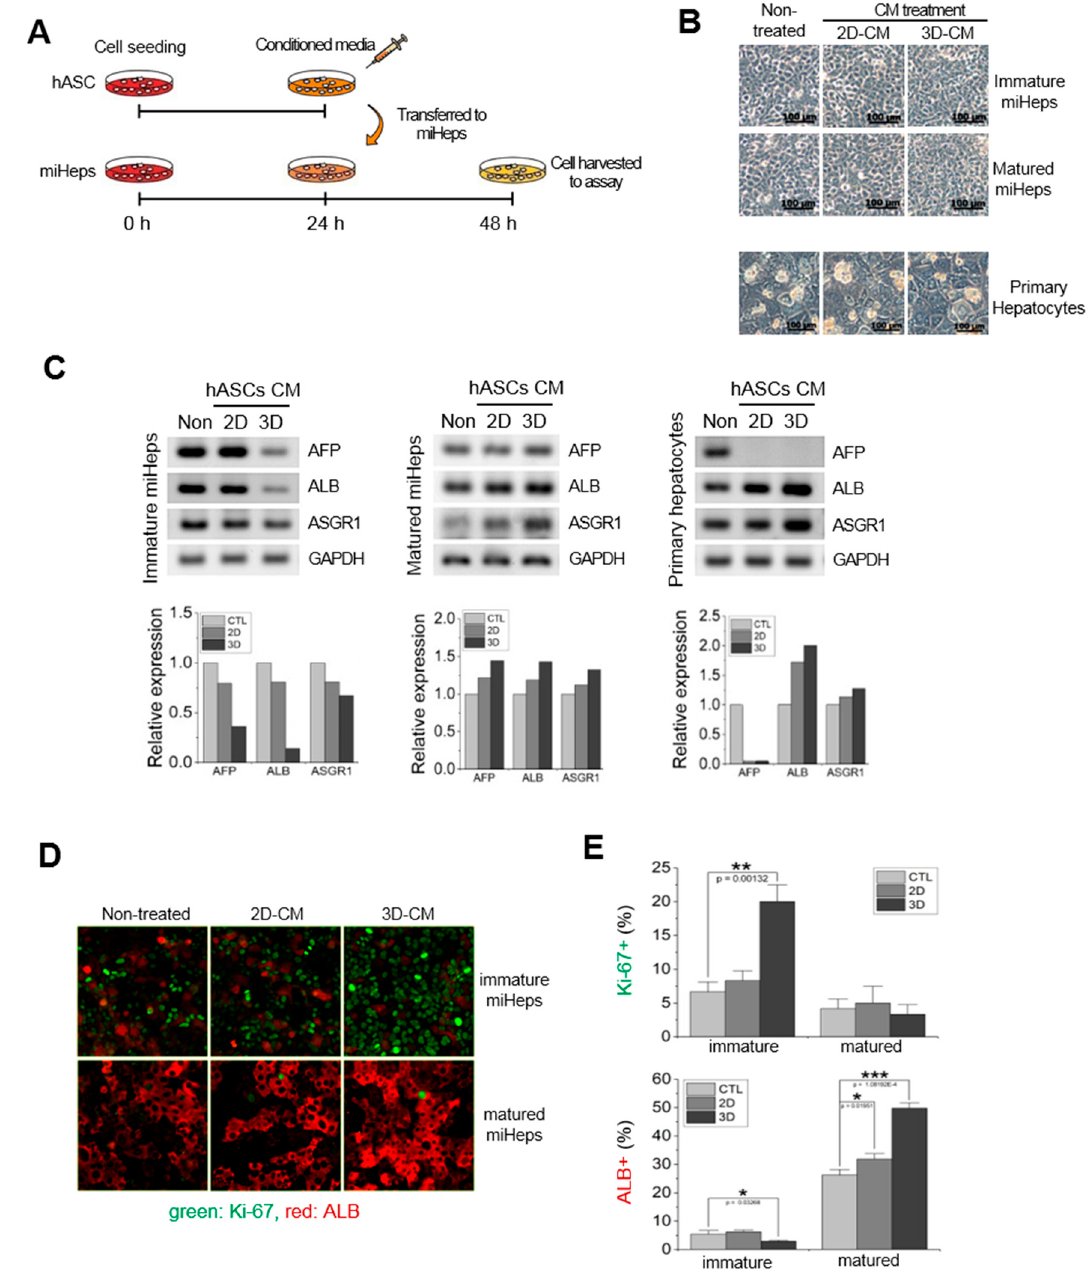
Figure 4. E ff ects of hASC conditioned media on miHep hepatic function. ( A ) Schematic diagram of the experimental procedure. ( B ) Cell morphology of miHeps and primary hepatocytes treated with CM; 2D-CM, the CM of 2D-cultured hASCs; 3D-CM, the CM of 3D-cultured hASCs. ( C ) Reverse-transcription PCR analysis of hepatic gene expression in hASC CM-treated miHeps and primary hepatocytes. All measurements were conducted 24 h after CM treatment. ( D ) Immunostaining of Ki-67 (green) and ALB (red) in immature and mature miHeps treated with hASC-CM. ( E ) Quantification of Ki-67 + and ALB + cells. The percentage was normalized to the total cell count. Data represent the mean ± SD, * p < 0.05; ** p < 0.005; *** p < 0.0005.